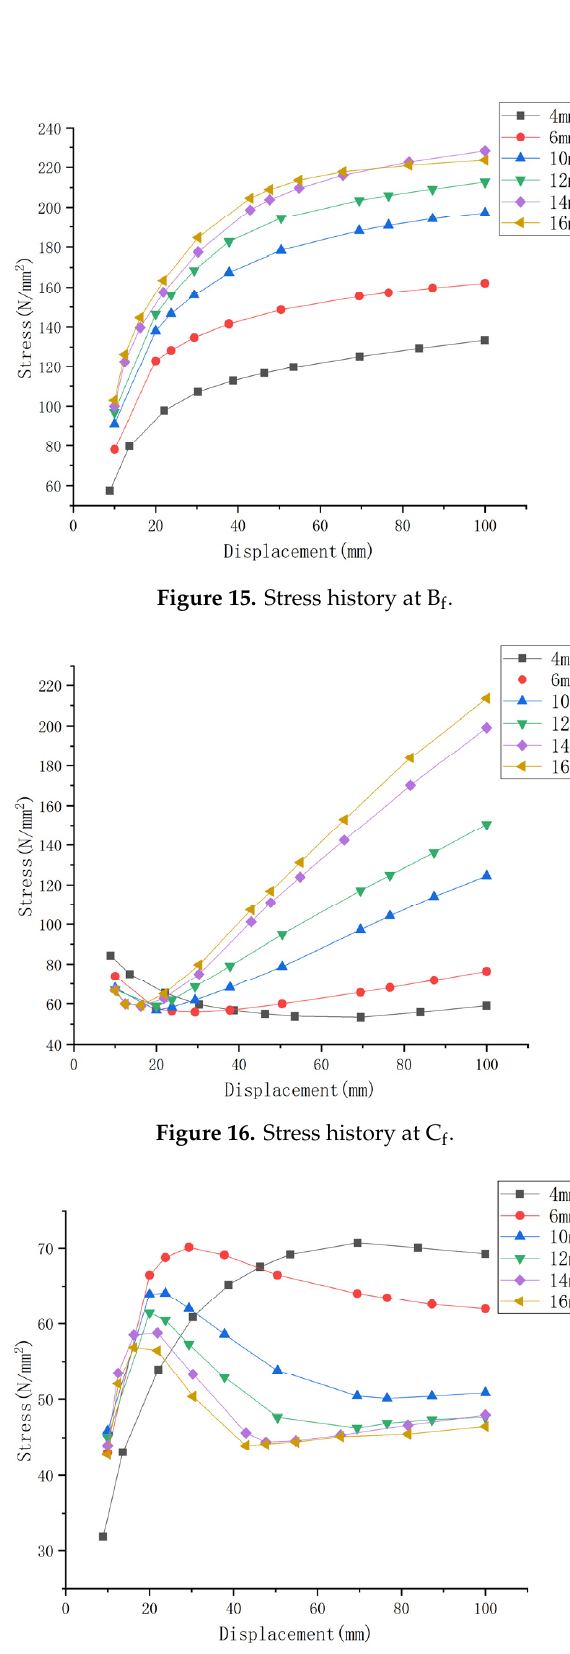
Figure 17. Stress history at C p .